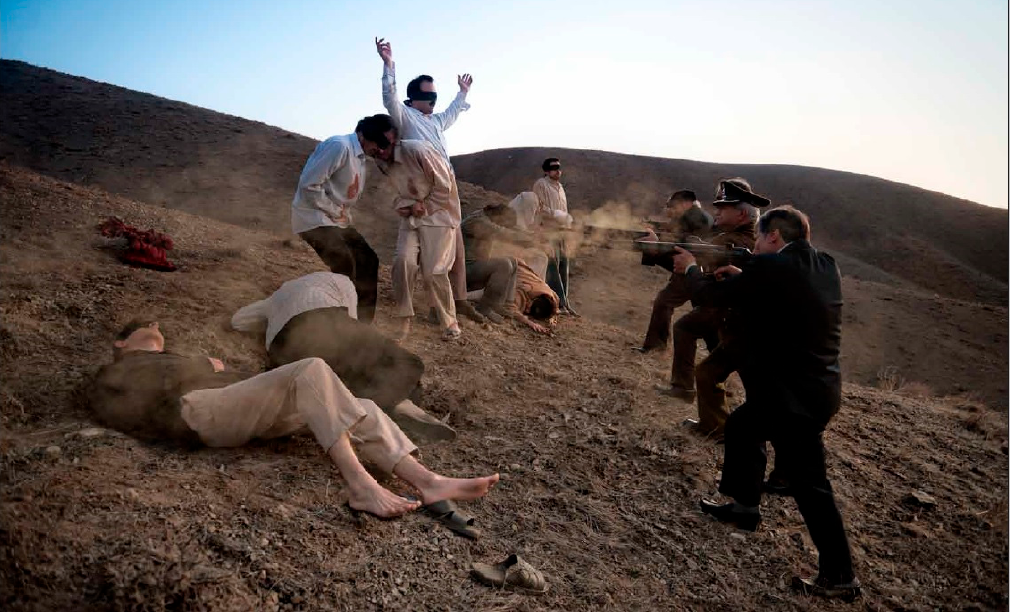
Figure 2. Azade Akhlaghi, Evin Hills, Tehran, Bijan Jazani 18 April 1975 , 2012, digital print on photo paper, 110 × 209 cm.